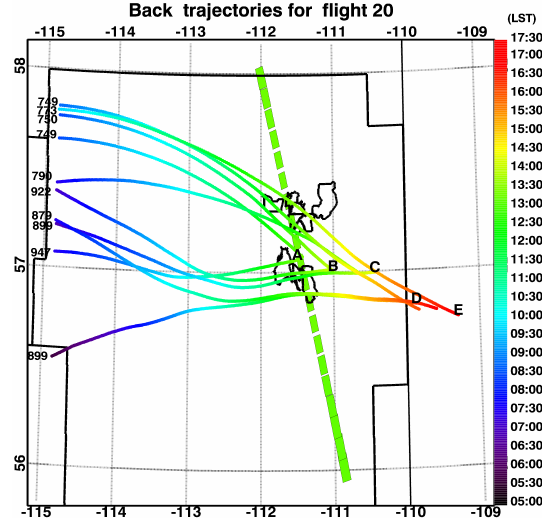
Figure 2. Model-generated back trajectories for JOSM flight 20 on 5 September 2013 over the Canadian oil sands region plotted spa- tially as a function of local standard time (LST). The boundaries of the oil sands region are outlined with black lines, with the surface mining areas indicated within this region near the centre of the plot. Each aircraft “profile” (either the up or down profile) is indicated al- phabetically in measurement succession during the afternoon (e.g. “A” is at 13:22LST (TES overpass time) and “E” later in the af- ternoon at 17:00LST). Plotted for each of these aircraft profiles are two back trajectories plotted corresponding to the lowest aircraft altitude and the ∼ 750hPa aircraft profile levels, which spans the general vertical range where the satellite is most sensitive for NH 3 , HCOOH, and CH 3 OH. Also, plotted on the map are the TES foot- prints, colour coded by the overpass time